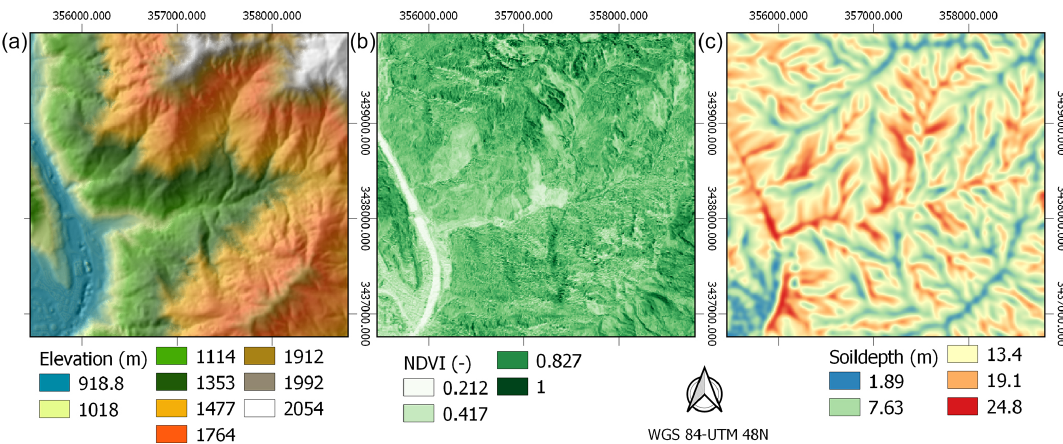
Figure 6. An overview of the input data for the first-stage simulation in Hongchun catchment: elevation model (a) , NDVI (b) , and modeled soil depth (c) .